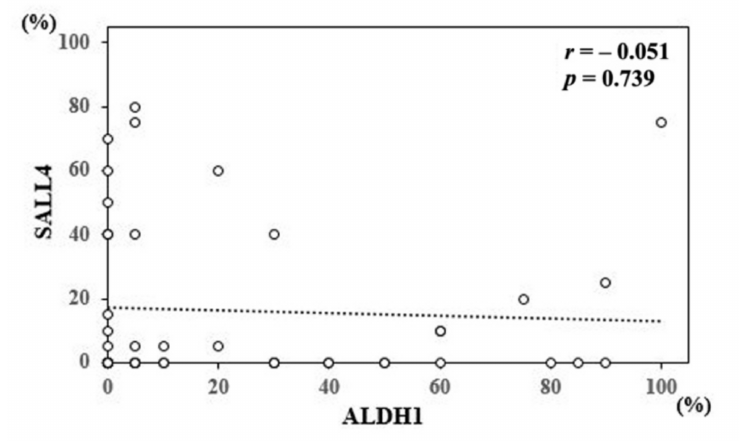
Figure 2. Correlation between aldehyde dehydrogenase 1 ( ALDH1 ) and Sal-like 4 ( SALL4 ) expres- sion. The expression of ALDH1 was not significantly correlated with that of SALL4.